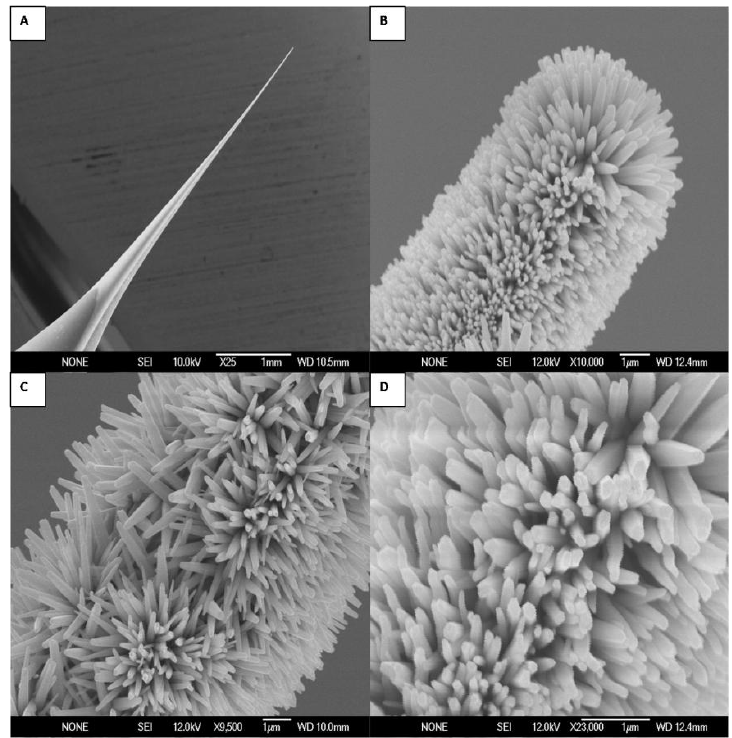
Figure 1. Field emission scanning electron microscope images at different magnifications of the Ag-coated glass capillary without ( A ) and with ( B – D ) grown ZnO nanorods using low temperature aqueous chemical solution